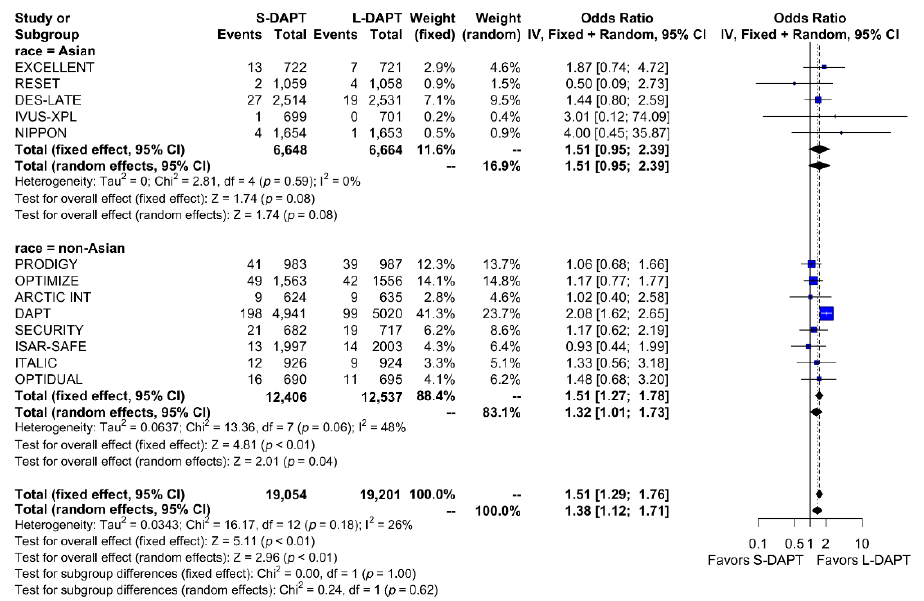
Figure 5. Myocardial infarction in randomized clinical trials. S-DAPT, short duration dual antiplatelet therapy; L-DAPT, long duration dual antiplatelet therapy; CI, confidence interval.